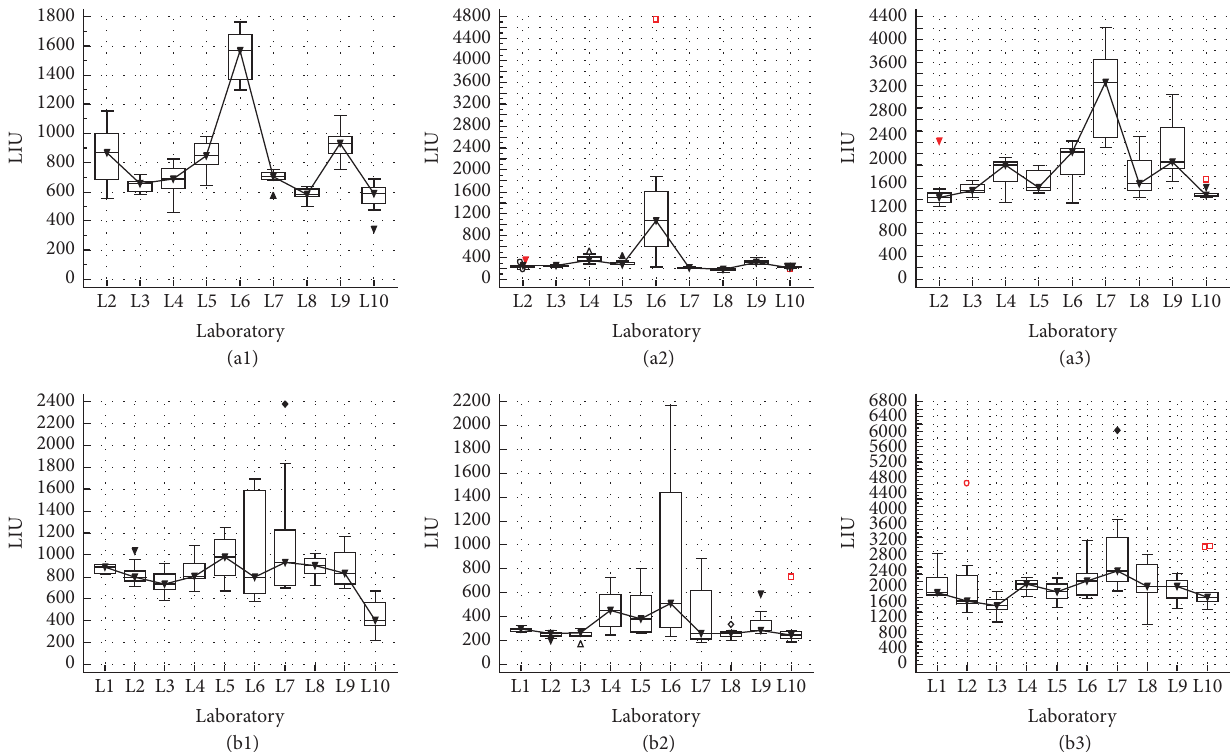
Figure 1: Results of the LIU intrarun variability for samples 1, 2, and 3 ((a1), (a2), and (a3), resp.) and LIU interrun variability for samples 1, 2, and 3 ((b1), (b2), and (b3), resp.) are shown for each individual laboratory before intervention at laboratory